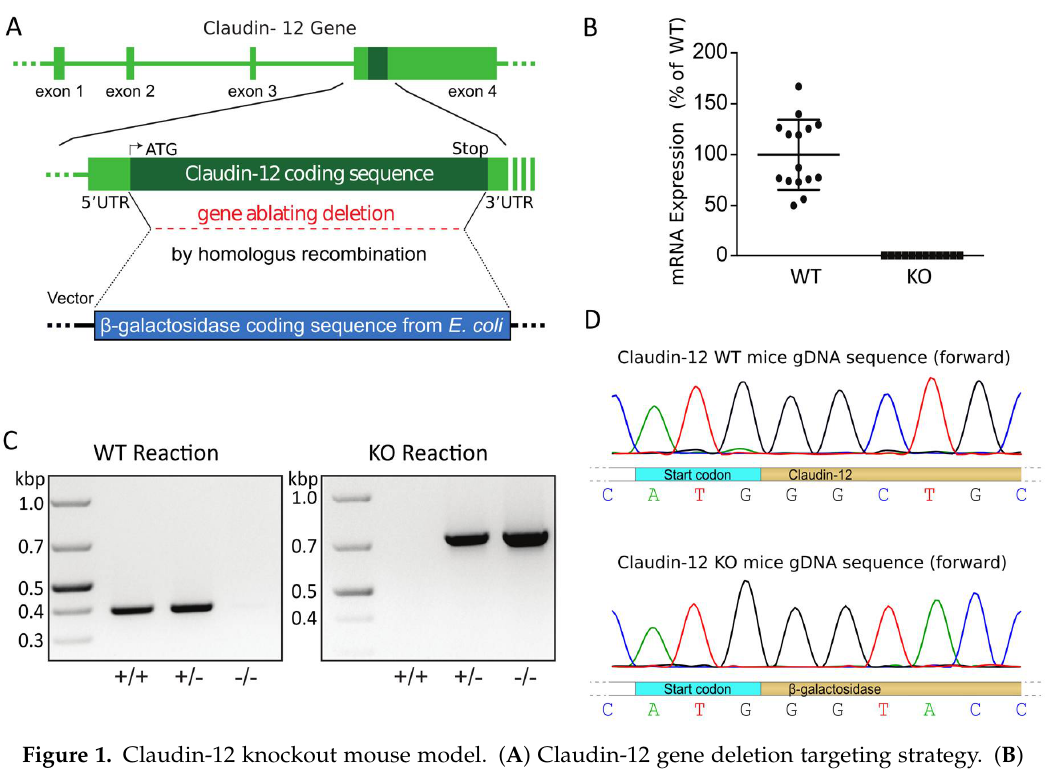
Figure 1. Claudin-12 knockout mouse model. ( A ) Claudin-12 gene deletion targeting strategy. ( B ) Relative claudin-12 mRNA expression normalized to GAPDH, from kidneys of wild type (WT) or claudin-12 knockout mice (KO). ( C ) Genotyping reactions of wild type ( +/+ ), heterozygous ( +/ − ), or claudin-12 knockout ( − / − ) mice using specific primers for the coding exon of claudin-12 (WT reaction) or the β -galactosidase coding sequence from E. coli (KO reaction). ( D ) Sequencing results of the gDNA sequence of claudin-12 WT or KO mice.